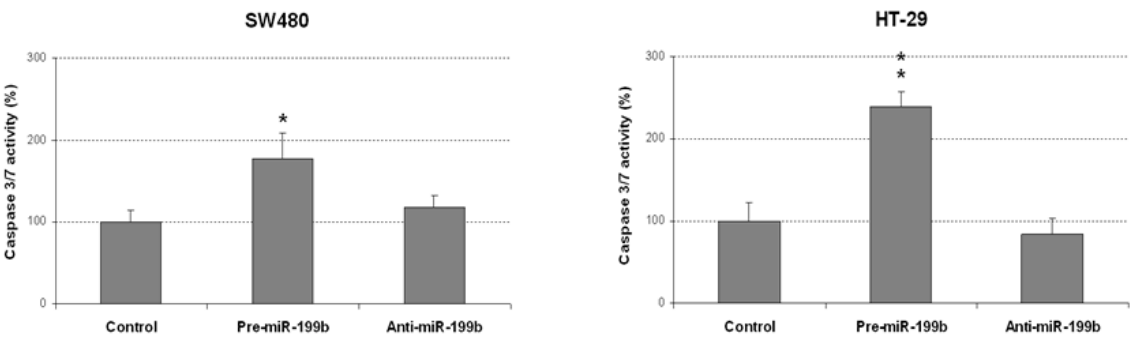
Figure 2. MiR-199b deregulation affects the colony-forming ability of CRC cells. Colony-forming assays showing the effect on the anchorage-independent cell growth of SW480 and HT-29 cell lines after ectopic miR-199b silencing or overexpression; * p < 0.05; ** p < 0.01. Scale bar: 200 µm.